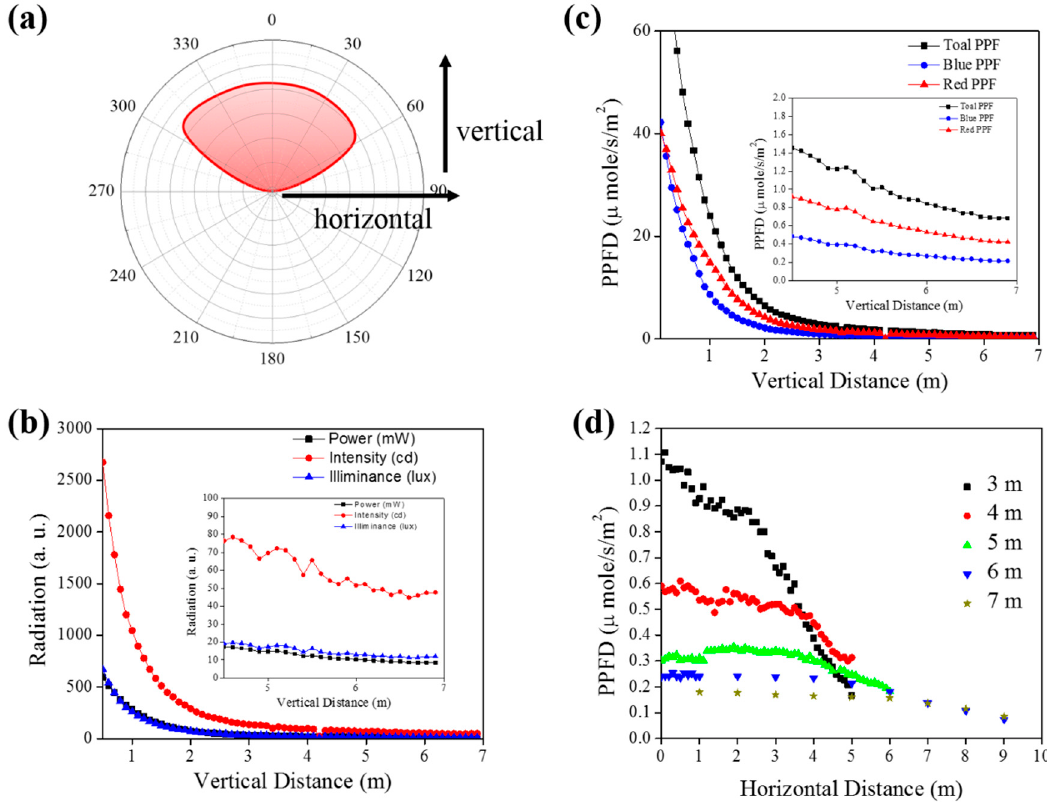
Figure 6. ( a ) Distribution pattern of the 136 × 78 lens design of the LED module. ( b ) Total LED intensity containing blue and red light dependent on the measured distance. ( c ) LED light intensity (in photosynthetic photon flux density, PPFD, unit) dependent on the vertical distance. ( d ) Blue LED light intensity (in PPFD unit) dependent on the horizontal distance.